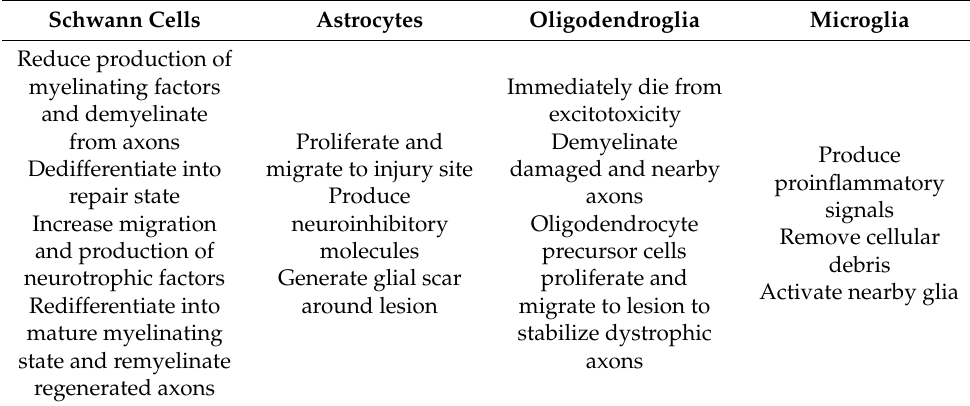
Table 1. Summary of glial cell response to traumatic